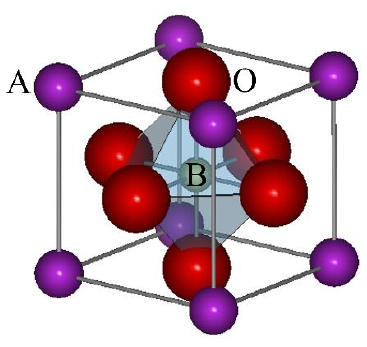
Figure 1. Simple perovskite structure expressed as ABO 3 .